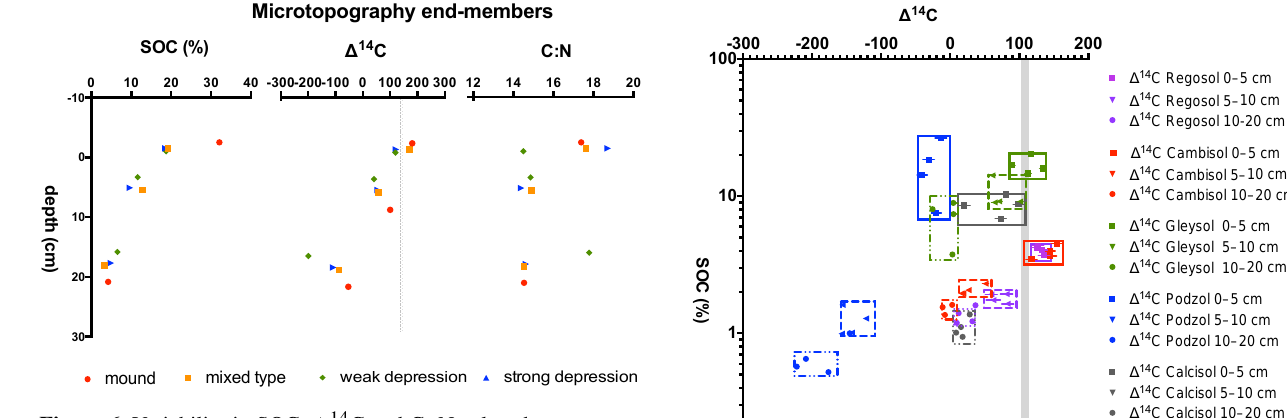
Figure 6. Variability in SOC, (cid:49) 14 C and C:N values between sep-